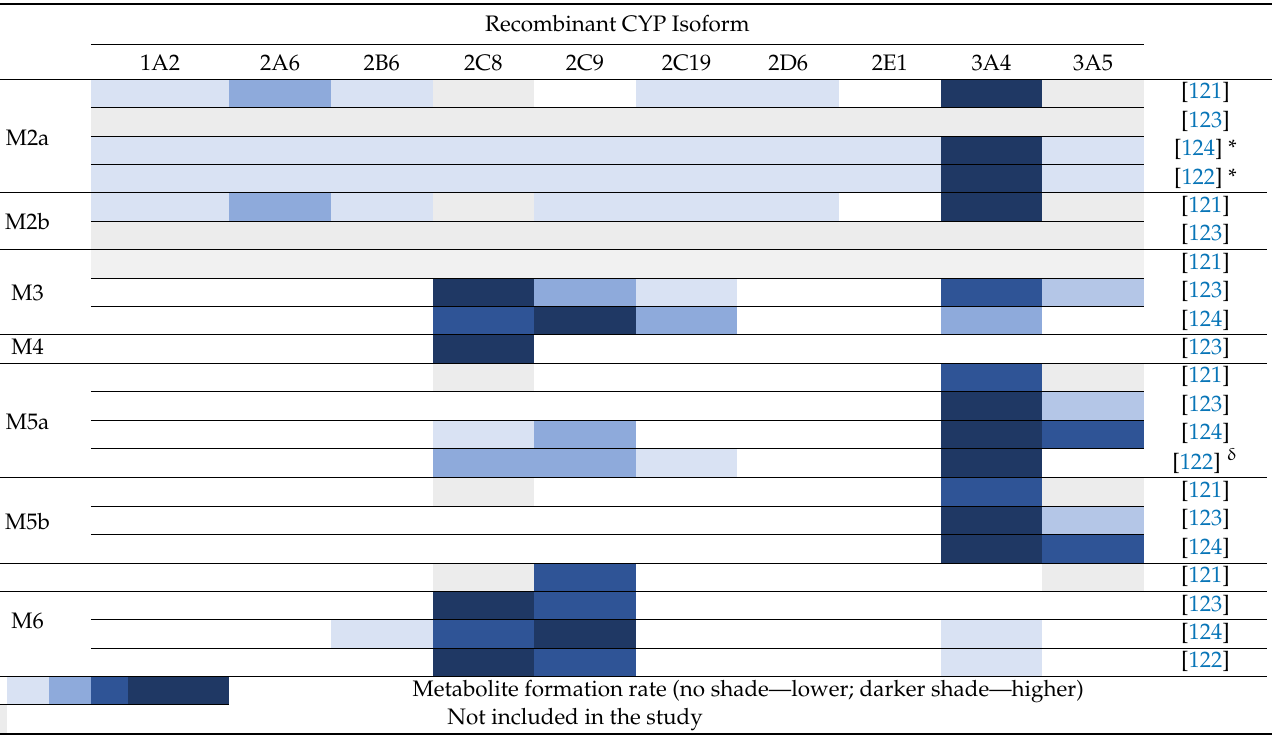
Table 1. Contribution of different CYP isoforms to MTK metabolism in human liver microsomes. The colour gradient indicates the relative contribution of each CYP isoform: the darker the shade, the more relevant is the CYP isoform